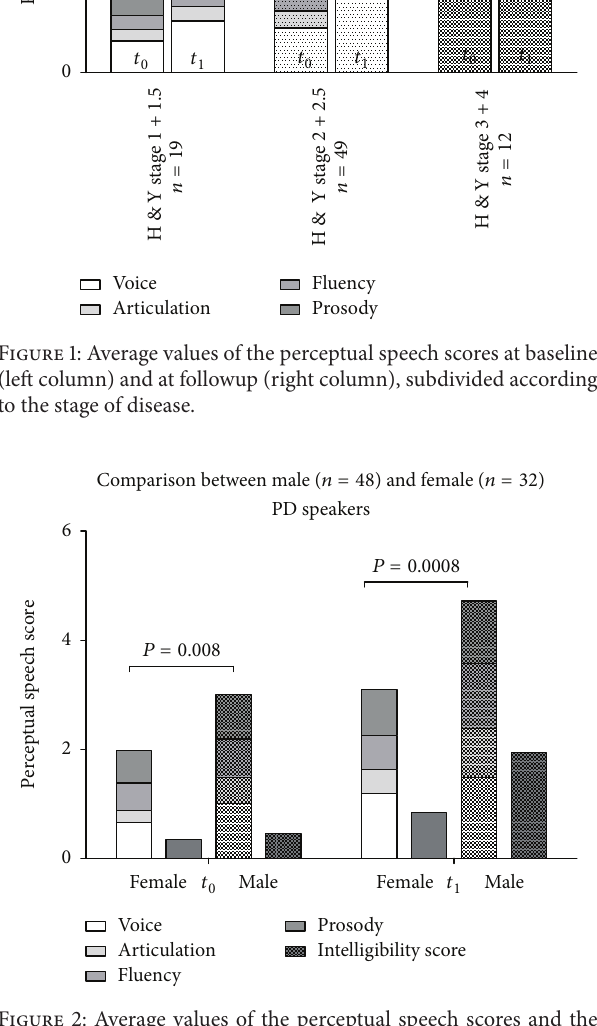
Figure 2: Average values of the perceptual speech scores and the intelligibility score at baseline in female and male speakers at base- line (left column) and at followup (right